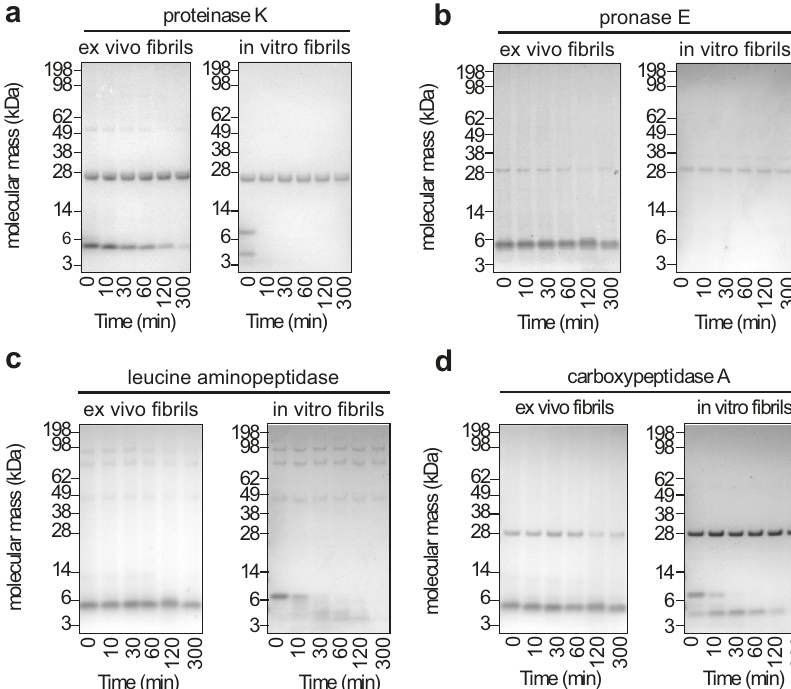
Fig. 5 Stability of the fi brils against proteolysis. Coomassie-stained denaturing protein gels of ex vivo AA amyloid fi brils and in vitro formed SAA1.1 fi brils that were incubated with different proteases for up to 300 min: proteinase K ( a , n = 3) and three other proteases (pronase E ( b ), leucine aminopeptidase ( c ) and carboxypeptidase A ( d ), n = 1). Bands above 14 kDa originate from the proteases. Due to the harsh proteolytic conditions used in this experiment there is discernible degradation of in vitro fi brils during sample workup for electrophoresis (0 min), speci fi cally with proteinase K and pronase